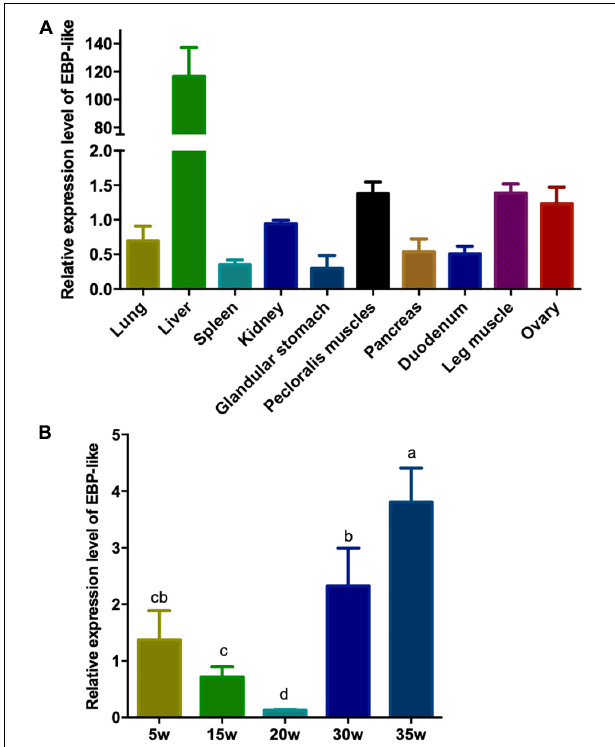
FIGURE 4 | EBP-like spatiotemporal expression profiles. (A) The relative expression level of EBP-like in different tissue of laying hens ( n = 6). (B) The relative expression level of EBP-like in liver tissue of chicken at different developmental stages ( n = 6). Note: all data are presented as mean ± SD ( n = 4–6), groups with different letters are significantly different ( P < 0.05), groups with same letters have no significant difference ( P >